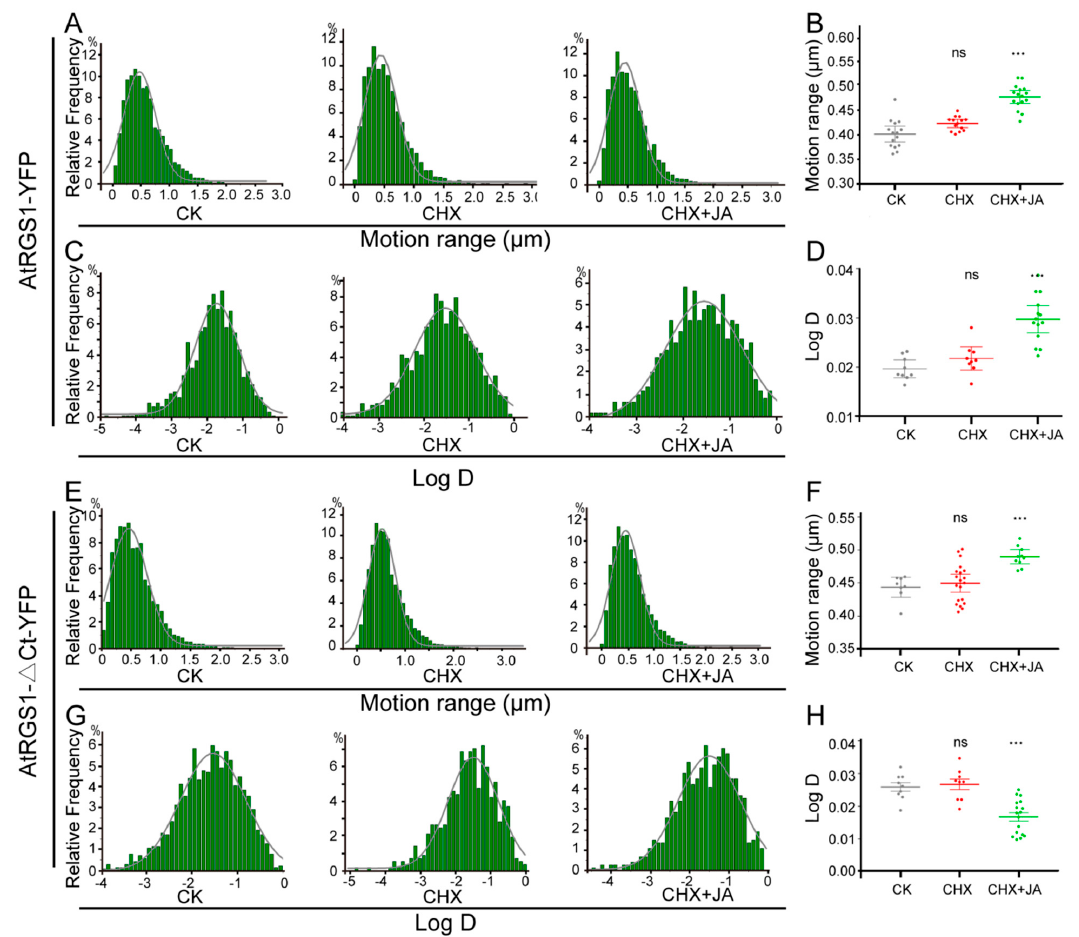
Figure 7. JA treatment affects PM dynamics of AtRGS1 and AtRGS1- Δ Ct. ( A , E ), Distribution of the motion range of AtRGS1-YFP ( A , n = 12589) and AtRGS1- Δ Ct-YFP ( E , n = 12776) without treatment (CK), with CHX treatment, and with MeJA treatment for 8 h plus CHX pretreatment. ( B , F ), The average frequency of the AtRGS1-YFP and AtRGS1- Δ Ct-YFP motion range under different conditions as ( A , E ). Error bars represent SD ( n = 8–20). Significant differences are denoted by asterisks (*** p < 0.001, ns, no significant difference, Student’s t test). ( C , G ): Distribution of the diffusion coefficients of AtRGS1-YFP ( C ) and AtRGS1- Δ Ct-YFP ( G ) without treatment (CK), with CHX treatment, and with MeJA treatment for 8 h plus CHX pretreatment. ( D , H ): The average frequency of AtRGS1-YFP and AtRGS1- Δ Ct-YFP diffusion coefficients under different conditions as ( C , G ). Error bars represent SD ( n = 8–20). Significant differences are denoted by asterisks (*** p < 0.001, ns, no significant difference, Student’s t test).